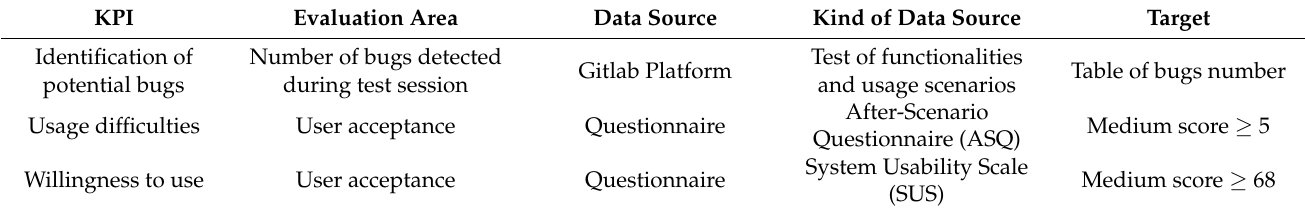
Table 5. Key performance indicators used during the prevalidation stage. KPI Evaluation